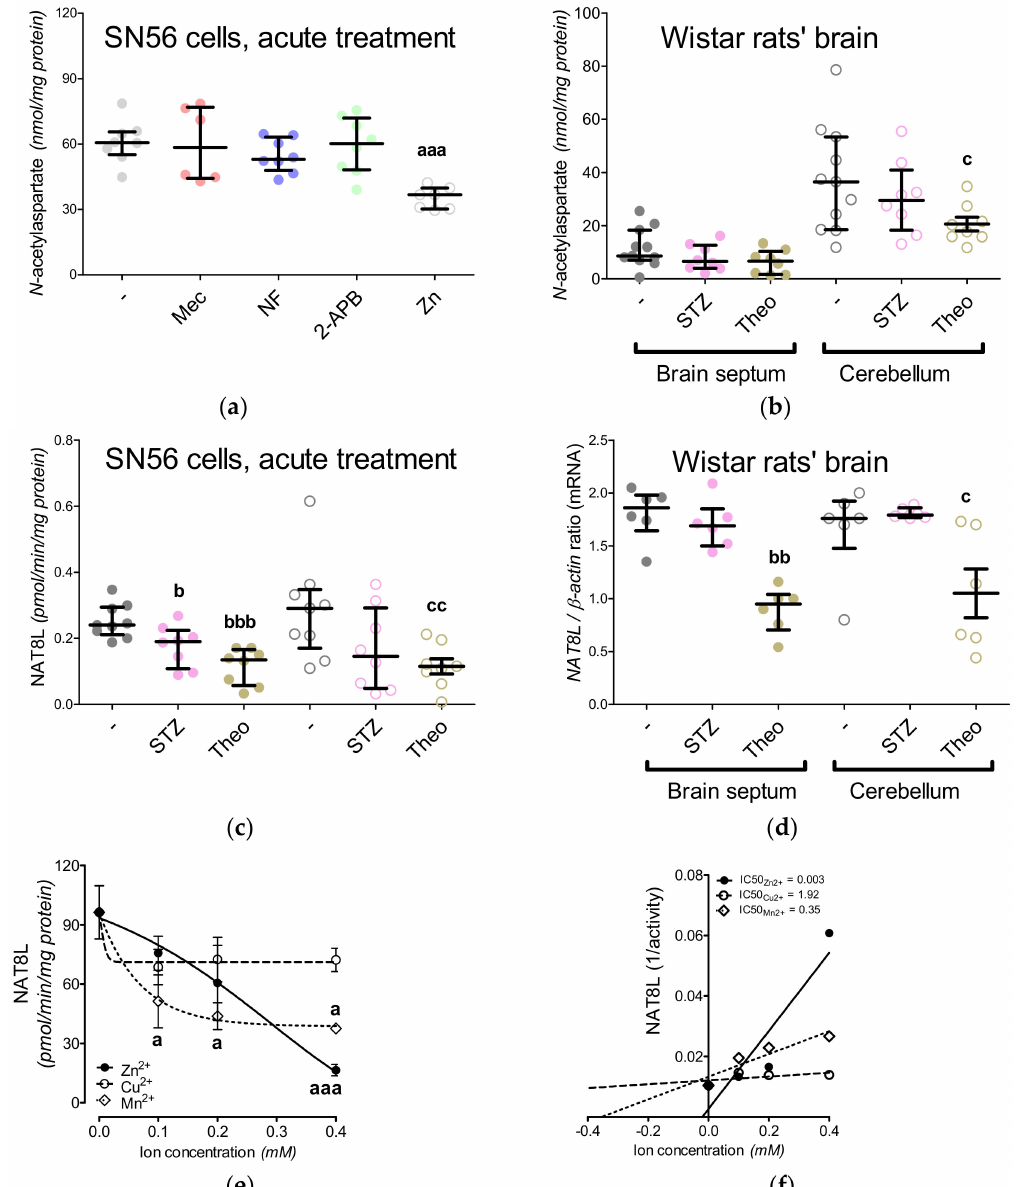
Figure 4. Characteristic features of aspartate N-acetyltransferase (NAT8L) measured in SN56 cells ( a , e , f ) and Wistar rat brain tissues ( b – d ), ( a , b ) N -acetylaspartate level; ( c ) NAT8L activity; ( d ) NAT8L mRNA level; ( e ) direct e ff ects of divalent transition-metal ions on NAT8L activity assayed in homogenized SN56 cells; ( f ) Dixon’s plot from calculated from data showed at Figure 4e. Data are median (25th–75th percentile) from 6–11 observations. Significantly di ff erent from SN56 control ( a — p < 0.05, aaa — p < 0.001) or Sham control brain septum ( b — p < 0.05, bb — p < 0.01, bbb — p < 0.001) or Sham control cerebellum ( c — p < 0.05, cc — p < 0.01). Abbreviations: 2-APB—0.050mM2-aminoethoxydiphenylborate, Mec—2 µ